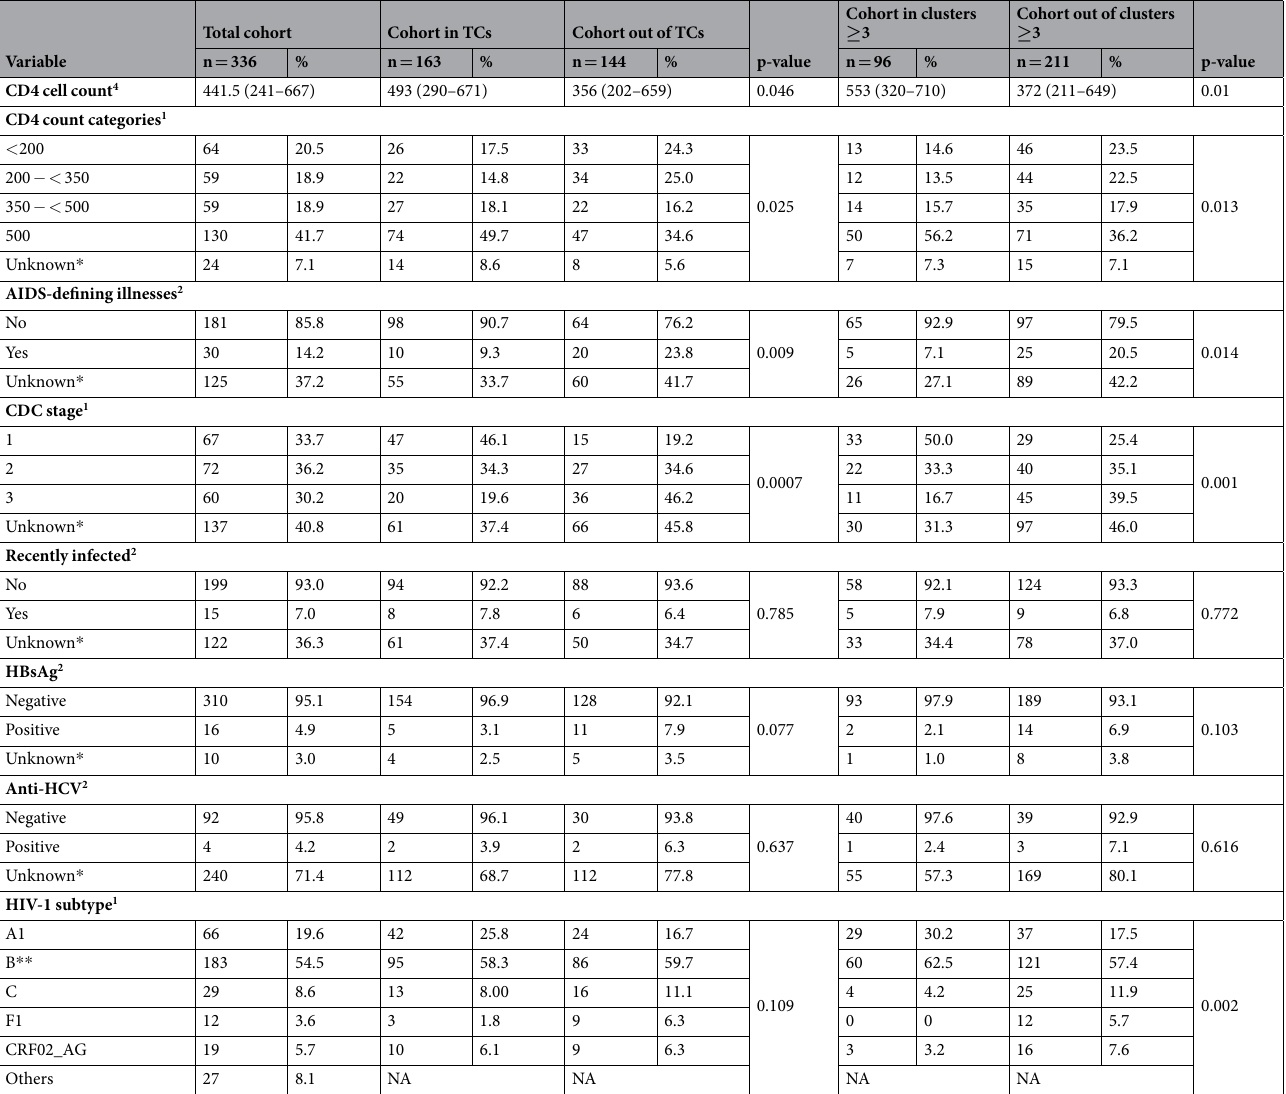
NA Table 1. Characteristics of the Cypriot cohort and the transmission clusters. The Cypriot cohort, the population in the TCs and the population in clusters are shown. Abbreviations: HCV: Hepatitis C virus; HBsAg: surface antigen of the hepatitis B virus; IQR: interquartile range; n: sample; MSM: men who have sex with men; p: p-value for the univariate analysis; SD: standard deviation; TCs: transmission clusters. * For each variable, the total unknown values are shown, but these values were excluded from the sum of proportions and the statistical analysis. ** Two subtype B sequences were excluded from the final alignment. 1 For categorical variables, associations were tested using Chi-squared test. 2 For categorical variables, associations were tested using Fisher’s exact test. 3 For continuous variables, associations were tested using t-test. 4 For continuous variables, associations were tested using Mann-Whitney U